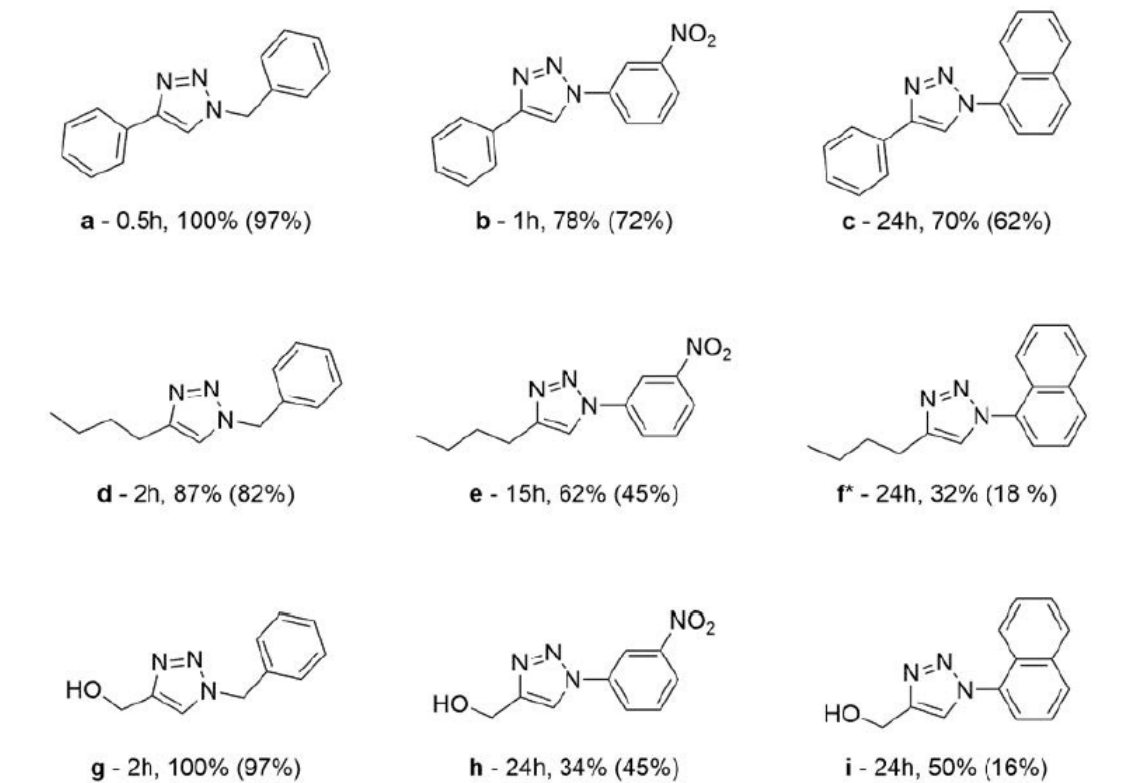
Scheme 4. Reaction conditions of catalysis scope using the chosen catalyst 2 NO3